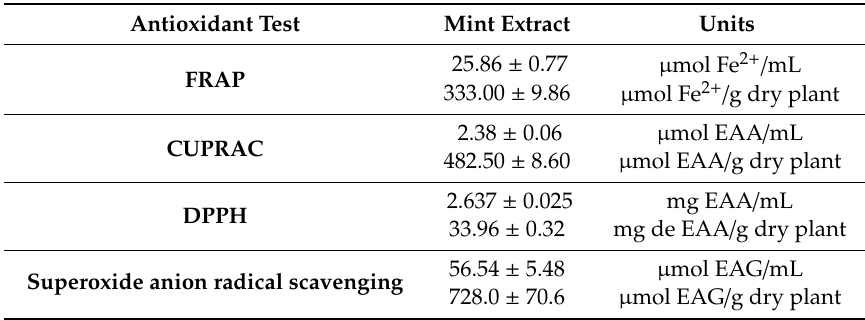
Table 2. Spearmint extract antioxidant activity.